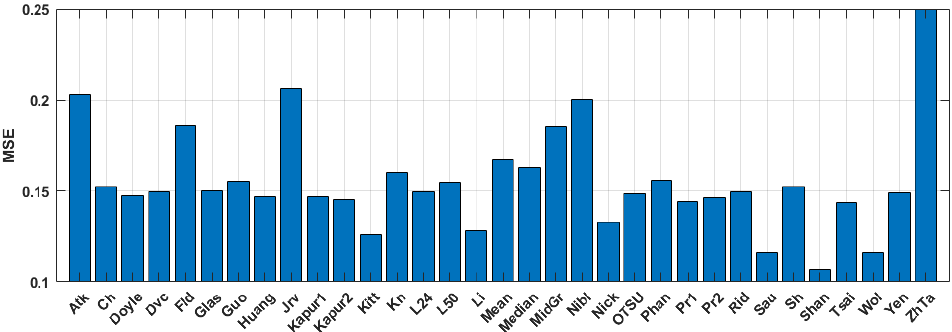
Figure 7. Average DE values for the binary amplitude inline Fresnel holograms. Changing the trajectory for error diffusion methods has a little effect on the recon- struction. This is due to the fact that original object images are halftone. Dot diffusion provides satisfactory SSIM and MSE values. However, DE is significantly lower com- pared to what the thresholding methods obtained. In result, the error diffusion is not well-suited for the third stage of the method of synthesis of amplitude inline Fresnel holograms. Target function is a superposition of NSTD and DE. Since DE is already low, for these methods, degrees of freedom to reduce the target function are limited. Thresh- olding methods with higher DE can provide better quality in the third stage. Dependencies of target function during the third stage of synthesis of the holograms vs. iteration number are shown in Figure 8. A single iteration is a go-round of all pixels of the hologram. Consequently, it consists of many pixel value changes and can be frac- tional. For comparison, two methods of hologram binarization were used: Otsu, and Sauvola ones. The contributions of NSTD and DE were equal in the target function. The object im age is “Baboon” (see Figure 1a). For better demonstration of the results, line corresponding to the best Otsu method value (i.e., for all 5 iterations) is also given. It can